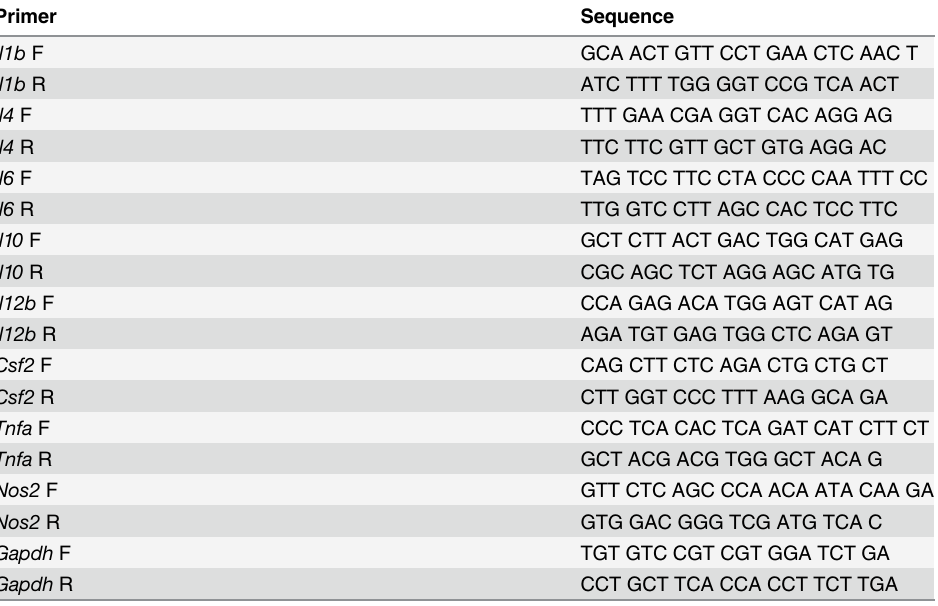
Table 1. Real-time polymerase chain reaction primers used in this